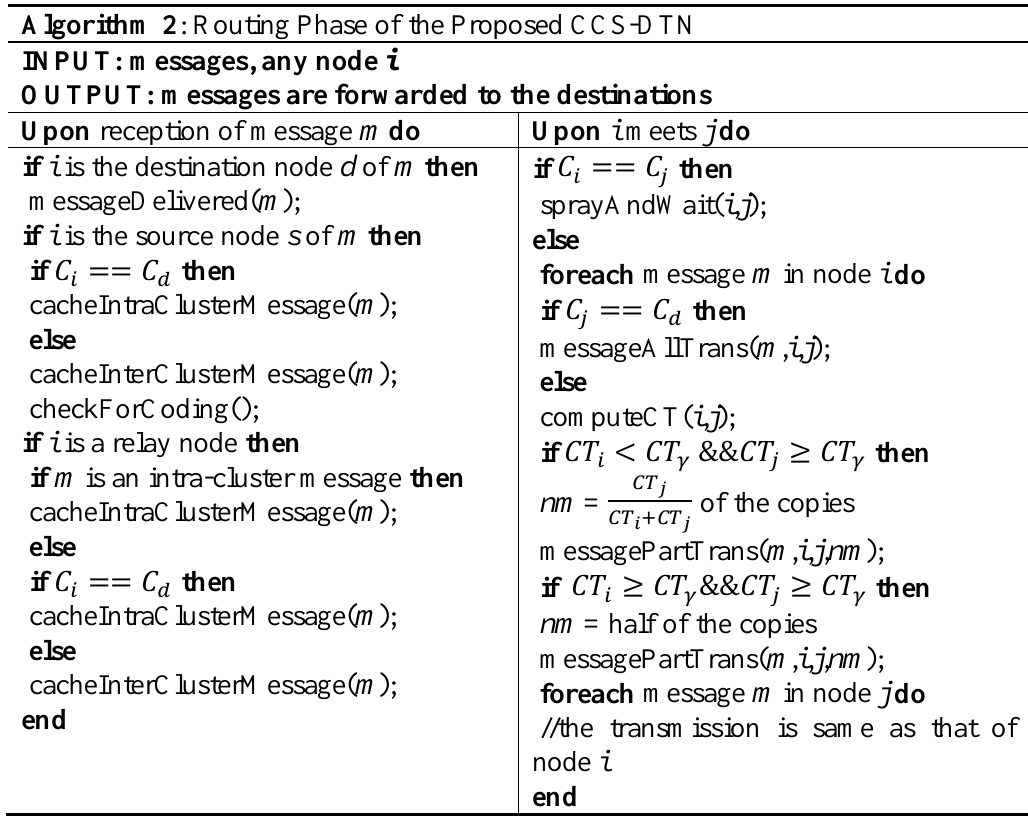
Algorithm 2 : Routing Phase of the Proposed